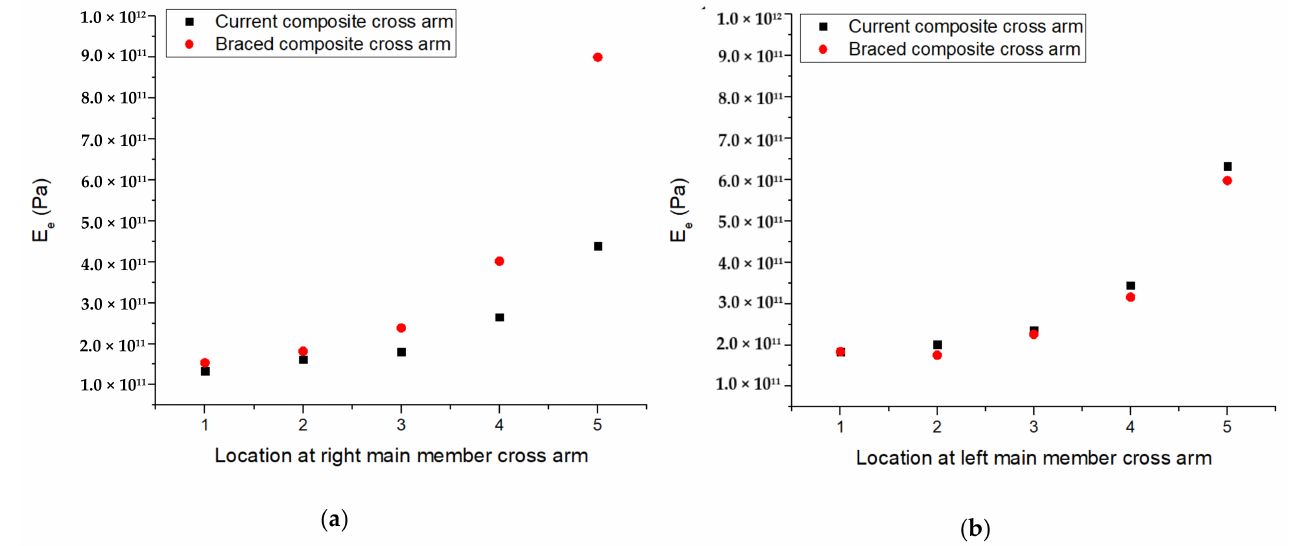
Figure 10. E e parameter for current and braced PGFRPC cross-arms: ( a ) right; ( b ) left main members. The viscoelasticity modulus was another parameter that was evaluated by using the Burger model. This parameter is vital for analyzing the relaxation response over time of a beam inside an interconnected structure, such as cross-arms. This parameter is also called the irrecoverable creep strain, which accounts for the relaxation coefficient of the viscoelastic property [55]. Figure 11 depicts the viscoelastic properties of the current and braced PGFRPC cross-arms in accordance with location along the main members. The viscoelastic modulus of the braced PGFRPC cross-arm had increased compared with that of the current PGFRPC cross-arm. This observation indicated that the addition of braced arms considerably improved the viscoelastic properties of the cross-arm structure; this improvement accounted for the enhancement in relaxation during creep [56].